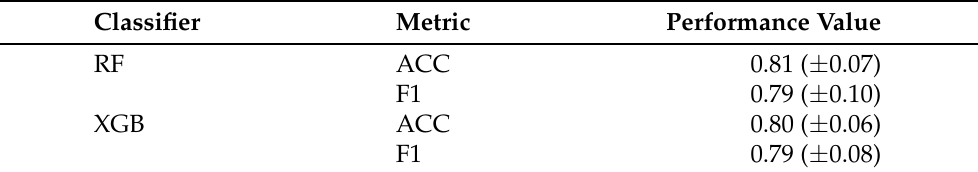
Table 3. Classifier performance for onboarding fraud detection based on features obtained from predictive PM.